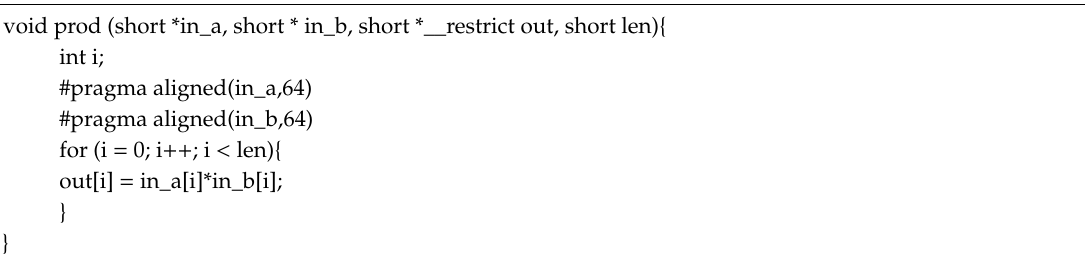
Algorithm 3. Calculate the dot product of two one-dimensional vectors of size 200. The function prod